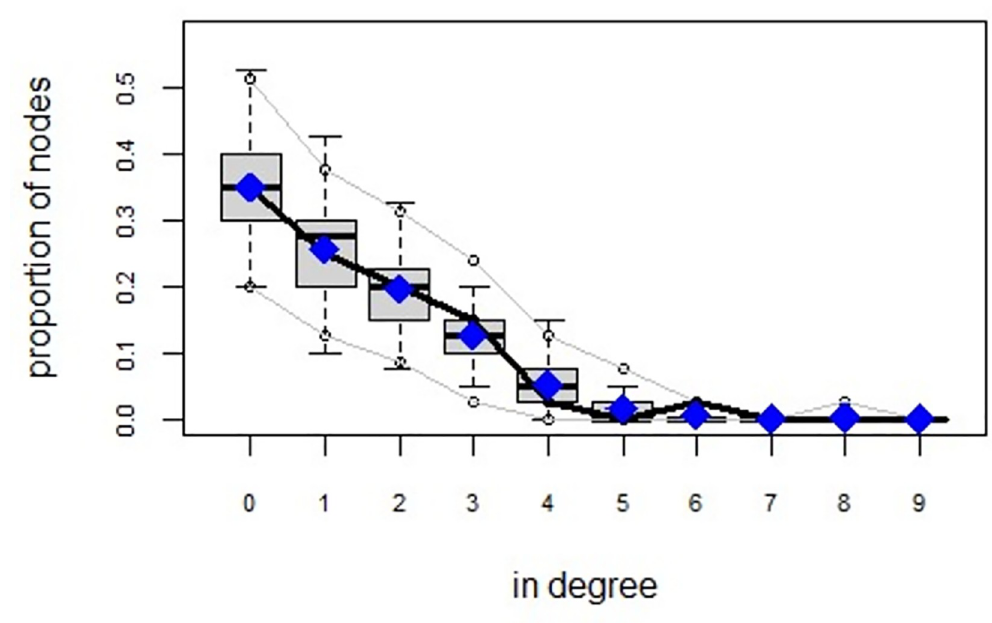
Fig 13. Multiplexity in the beta community—goodness of fit [24] in degree.